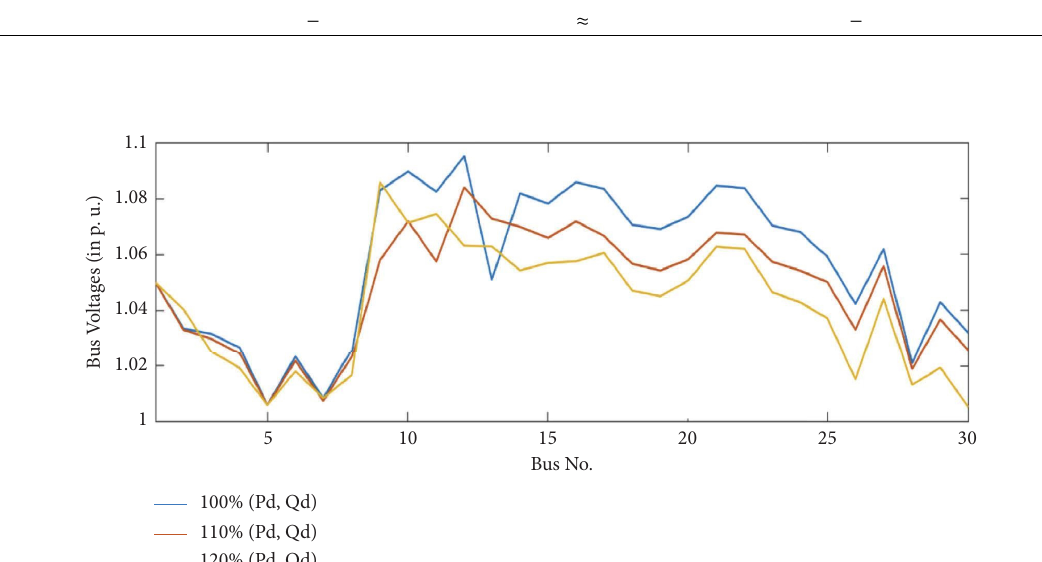
Figure 5: Bus voltage variation at diferent loadings in the IEEE-30 bus system.